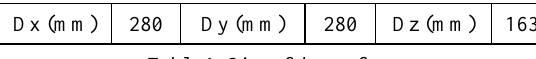
Table 1. Size of the surfaces